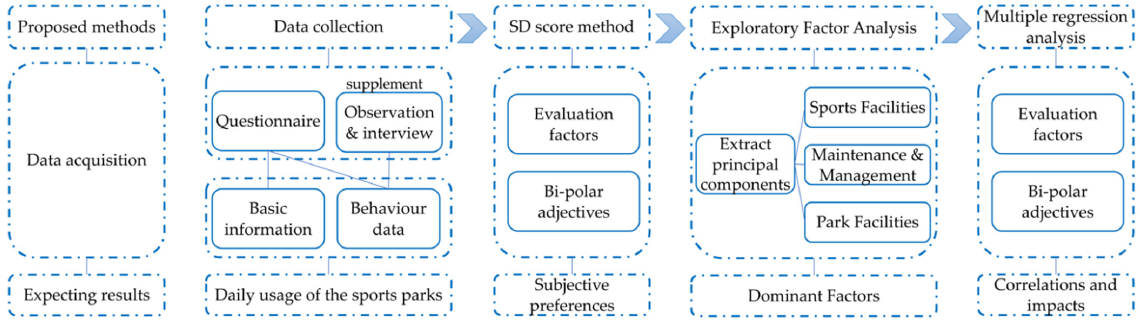
Figure 3. Research design.